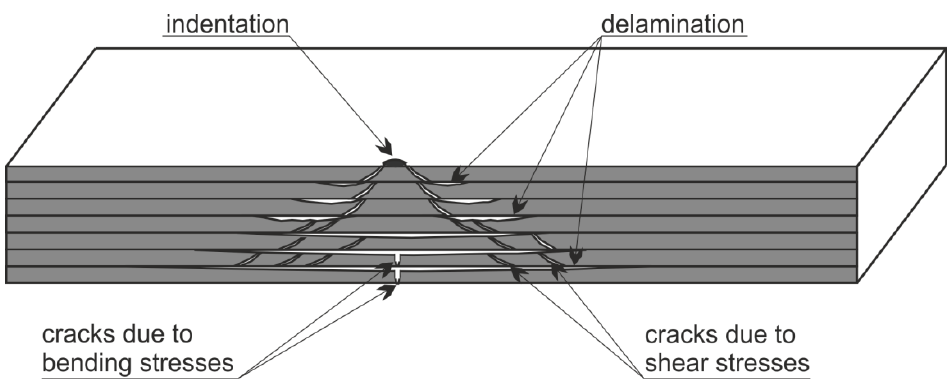
Figure 1. A scheme of barely visible impact damage (BVID) in a composite structure.